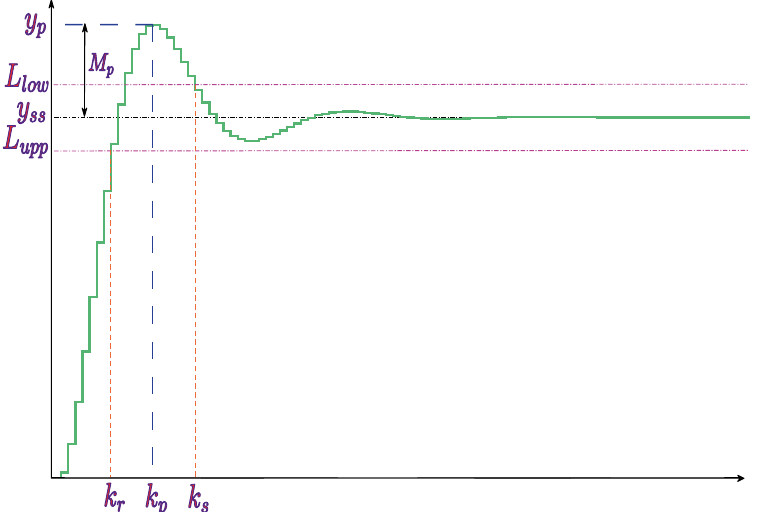
Figure 1. We illustrate the generic step response of a digital control system represented by Eq. (1), which emphasizes the settling time region bounded by L upp and L low and the maximum overshoot M p occurring at k p .